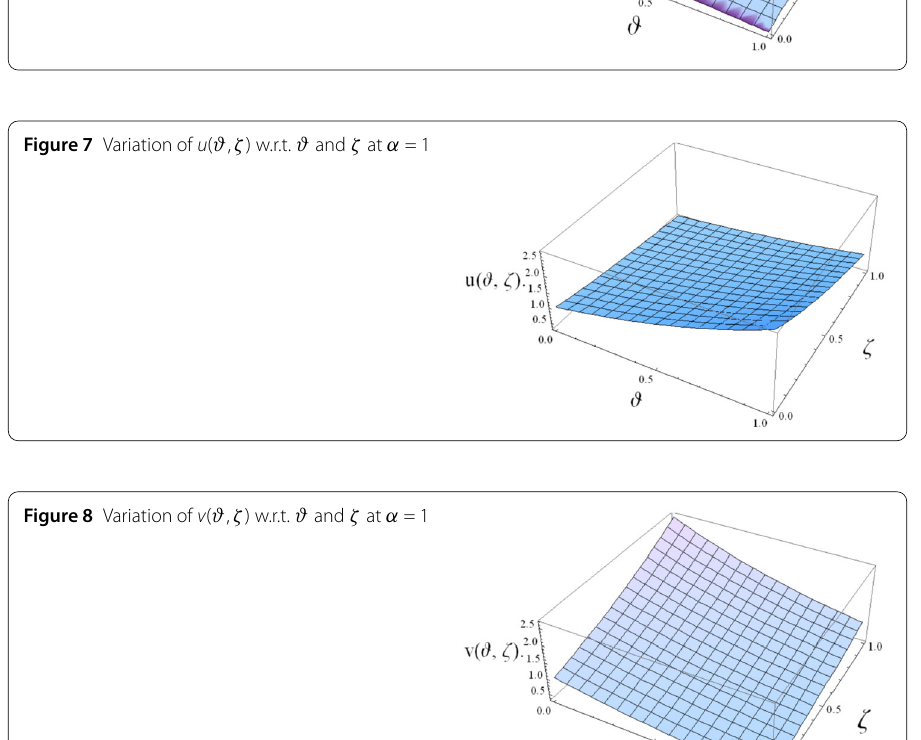
Figure 6 Variation of v ( ϑ , ζ ) w.r.t. ϑ and ζ at α = 2/3